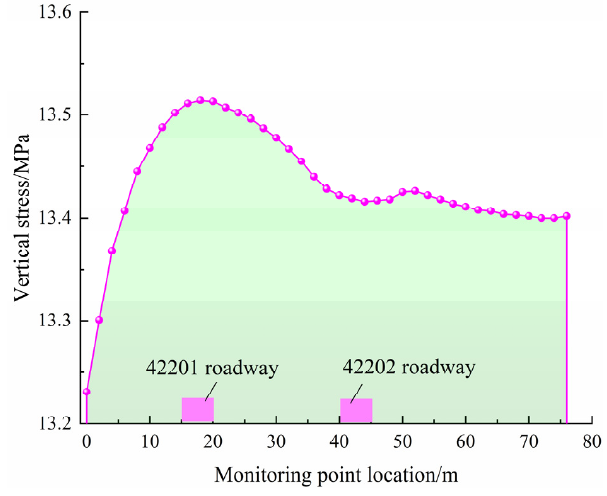
Figure 11. Abutment pressure distribution on the T-shaped remaining coal pillar.